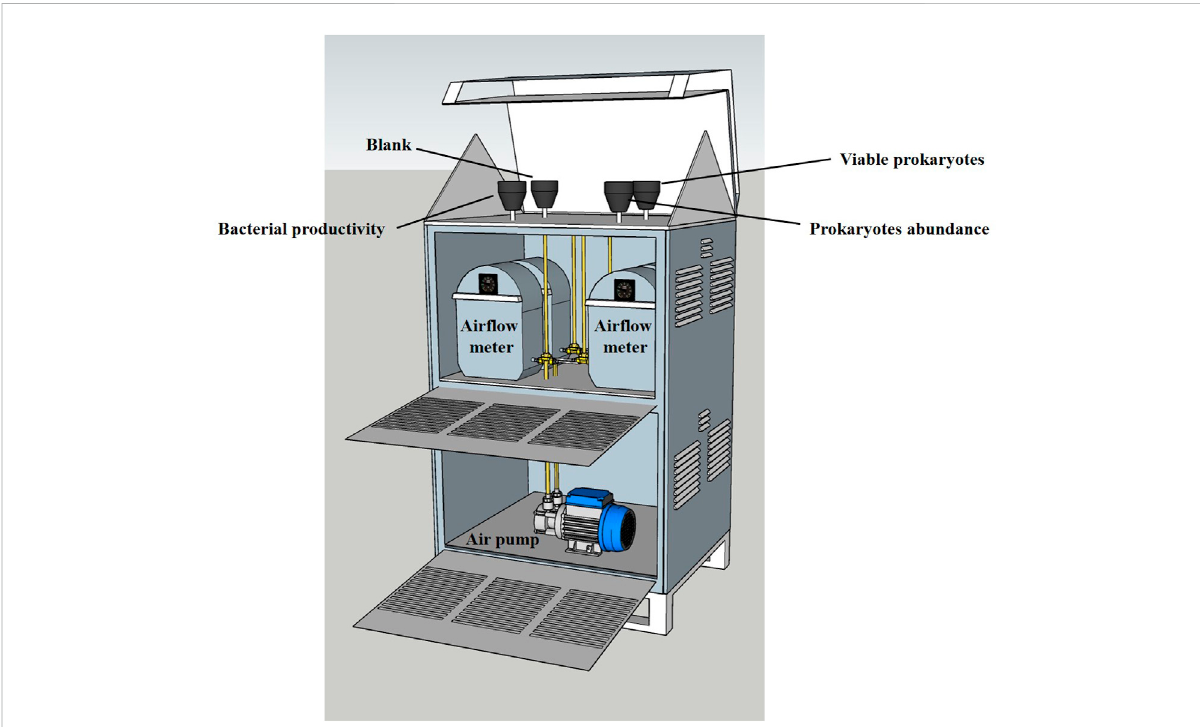
An illustration showing the custom-made high-volume sampler (40 m 3 h − 1 , 4 – 6 h in each sampling event) and the experimental setup used to collectaerosols.Thesamplerwaslocated~22 mabovesealevelattheSoutheasternMediterraneancoast.Thecollected fi lterswerelaterprocessed for measuring the potential viability proxy of airborne prokaryotes and their abundance ( n = 22). Blank fi lters placed on the fi lter holder without pumping was also collected and analyzed in each sampling event. Filters were collected throughout